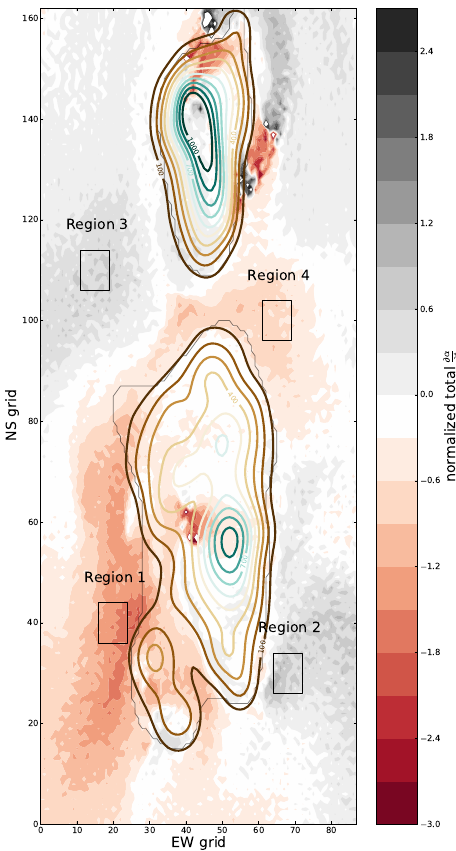
Figure 4. Total ∂α , averaged over daytime hours. Also shown are ∂t smoothed elevation contours and smoothed coastline. Regions 1, 2, 3 and 4 are identified for further dynamical